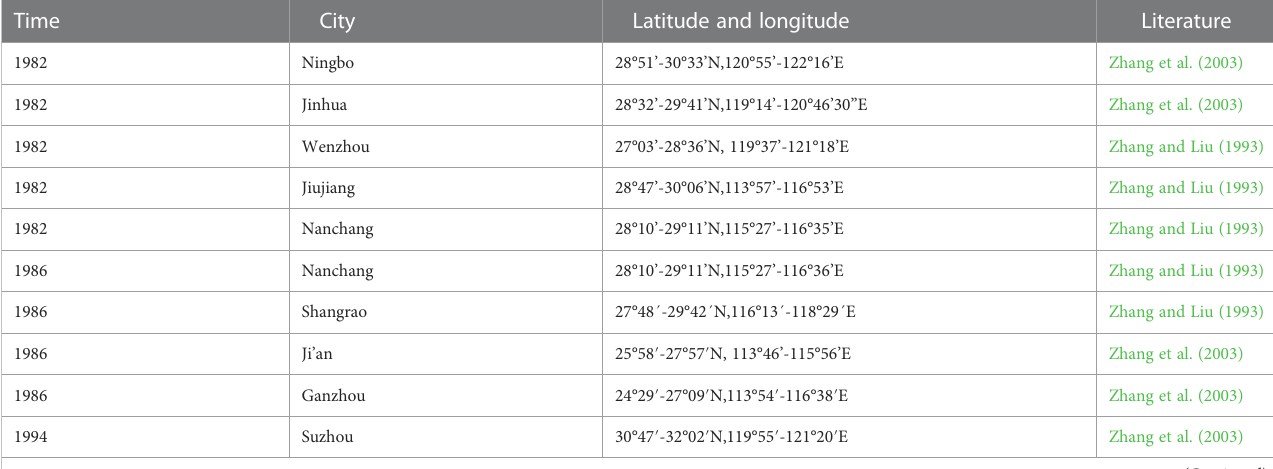
TABLE 4 Latitude and longitude of cities where historical drought events occurred. Time City Latitude and longitude